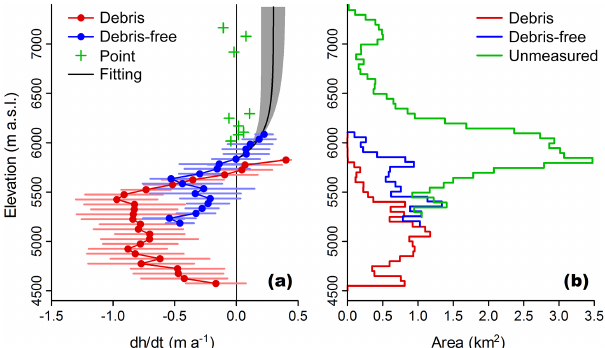
Figure 3. Elevation profiles of the (a) rate of elevation change (d h/ d t ) and (b) hypsometry of Kanchenjunga Glacier at 50m el- evation bands. The bars represent 1 standard deviation within each respective band. The green crosses and line denote the point mea- surements in the upper accumulation area (Fig. 2a) and the area distribution of the unmeasured part, respectively. The black line with gray shading is the best-fit curve for estimation of the elevation change in the unmeasured area (Case